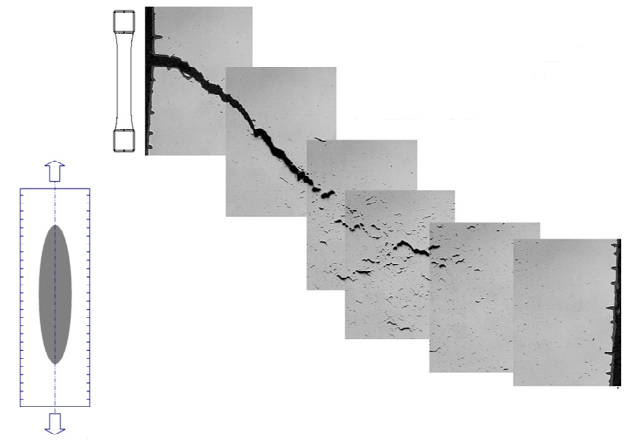
Figure 12. Creep ‐ fatigue crack development in a 1CrMoV rotor steel at 565 °C.